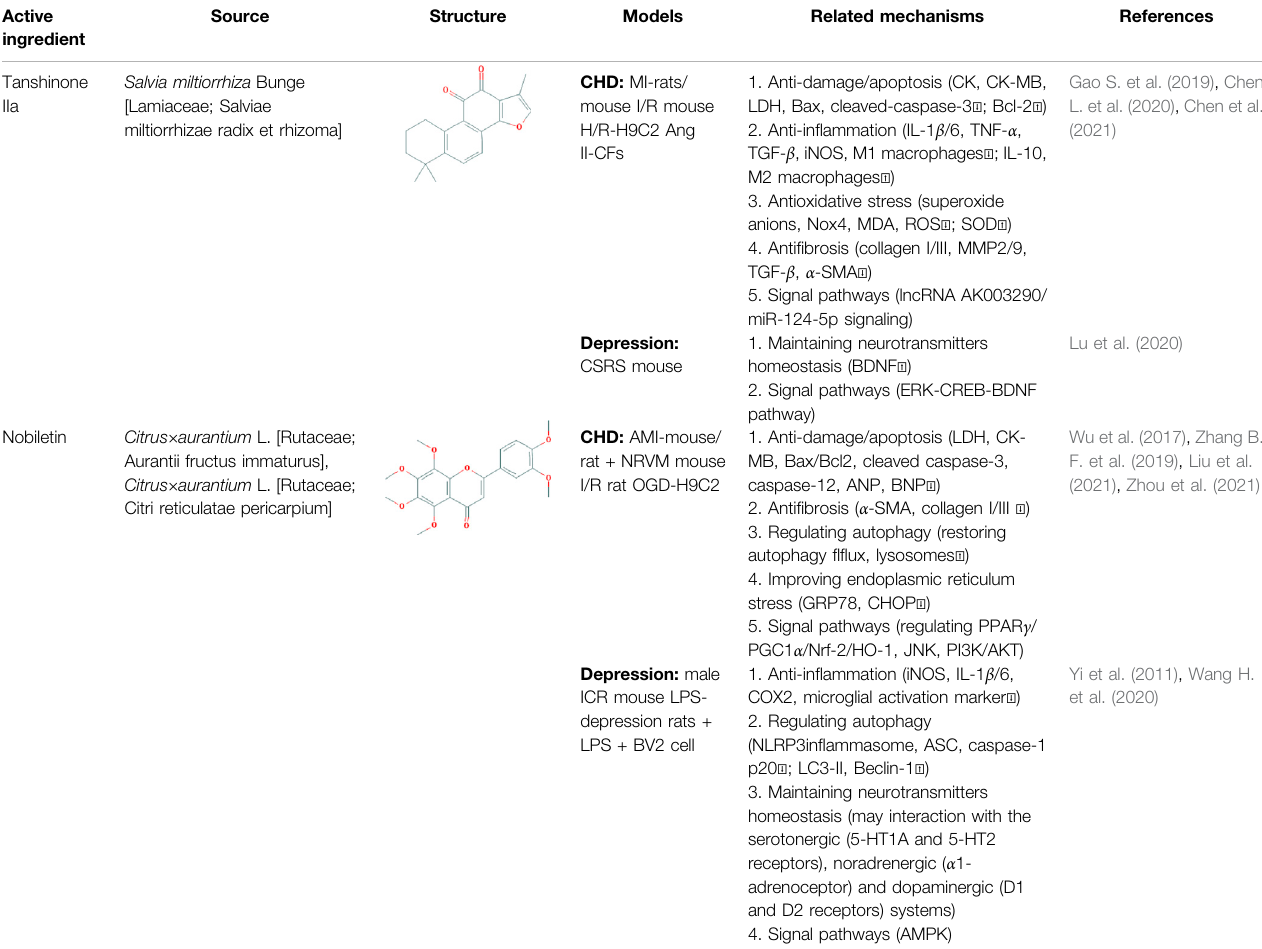
TABLE 3 | ( Continued ) Mechanisms of main active components of CHM on CHD with anxiety or